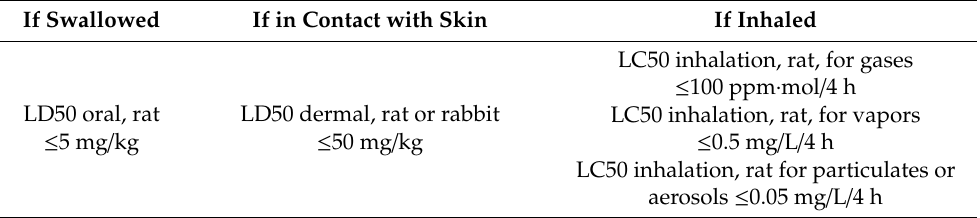
Table 3. Toxic service classification criteria according to the specifications of Shell.